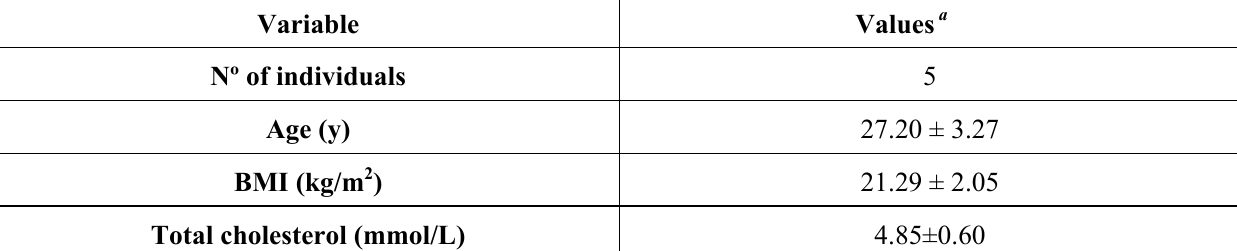
Table 2. Anthropometric characteristics and fasting blood lipids of subjects in the